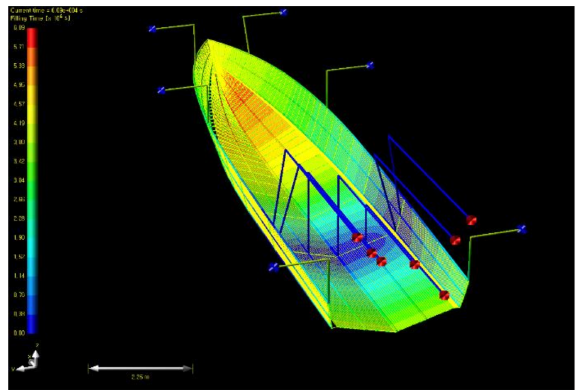
Figure 11. Resin flow analysis result of case 2 (filling